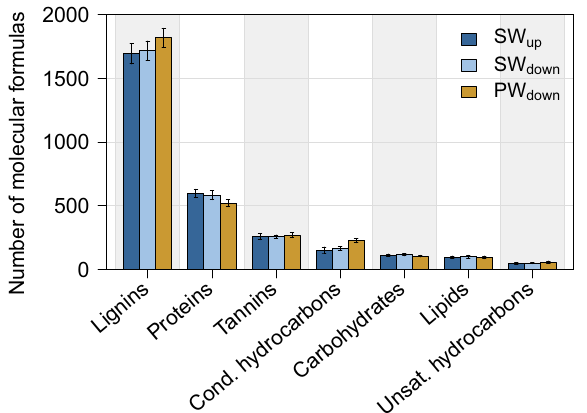
Figure 3. Number of molecular formulas grouped by DOM compound classes in surface water (SW) and pore water (PW) at upstream ( up ) and downstream ( down ) sites (n = 17, every 3 h over 48 h)Error bars indicate the standard deviation.